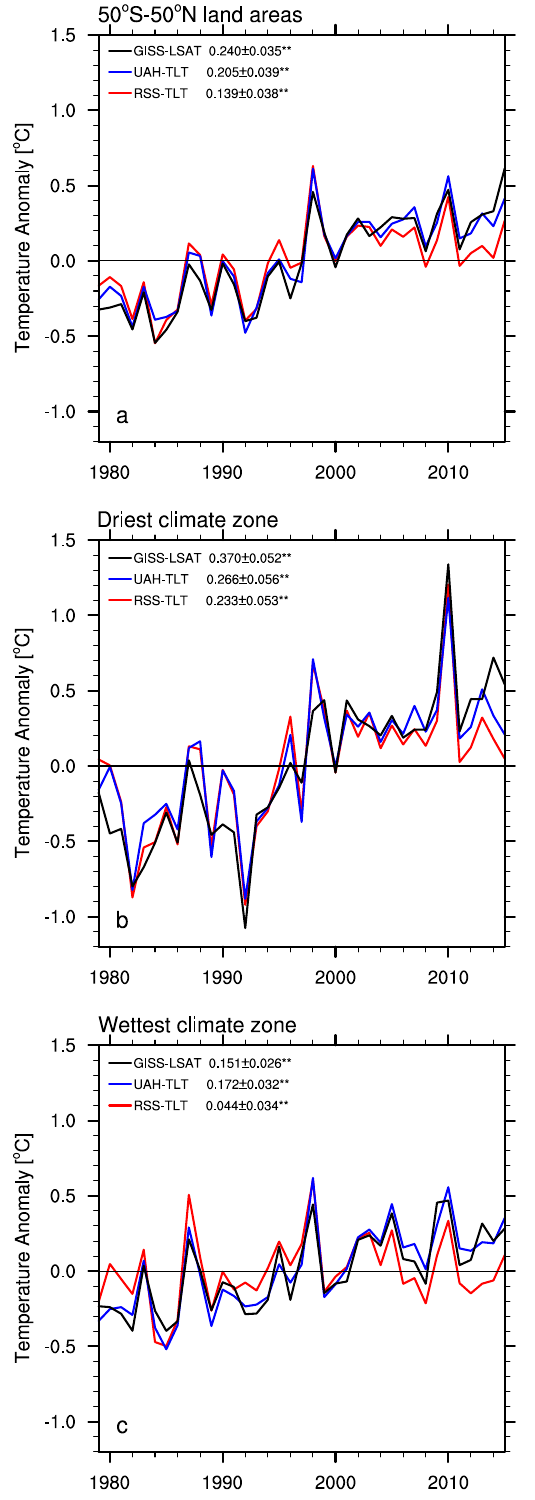
Figure 1. Zonal mean annual temperature anomalies (°C) for the period 1979–2015 from RSS-TLT, UAH-TLT and GISS-LSAT averaged over ( a ) the entire study region, and over the ( b ) driest and ( c ) wettest from the 12 large-scale climate zones classified by precipitation. Linear trends (°C/decade) ± one standard deviation with ‘ ** ’ are statistically significant (p <